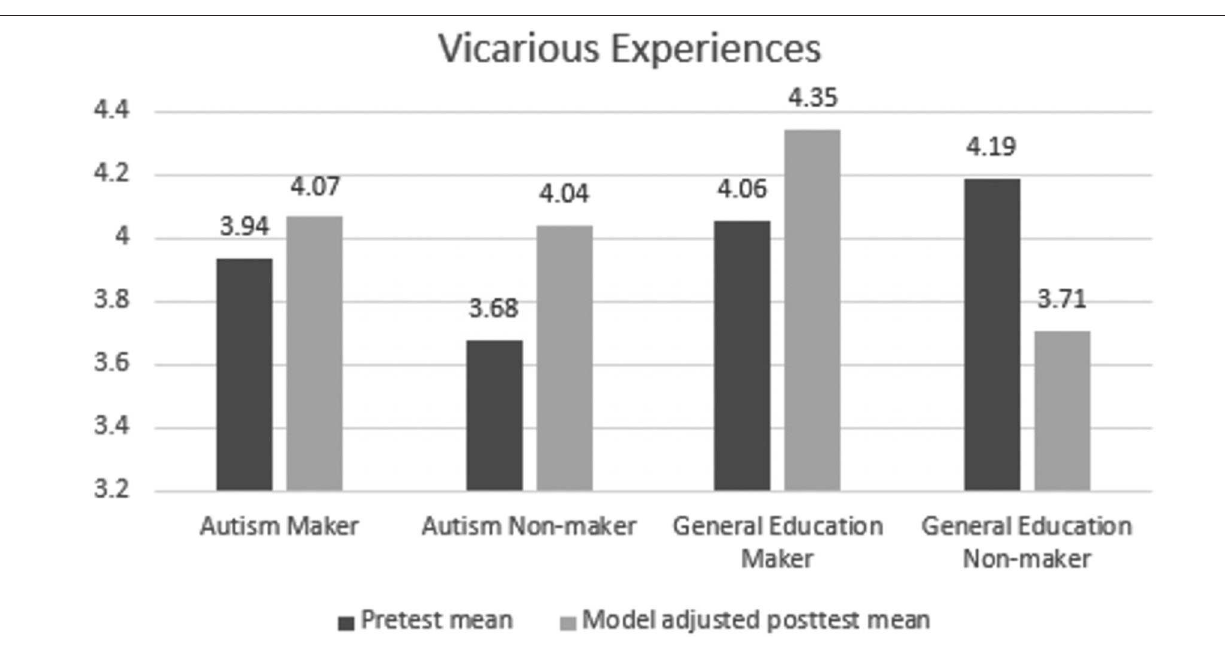
FIGURE 5 | Estimated means for the Vicarious Experiences